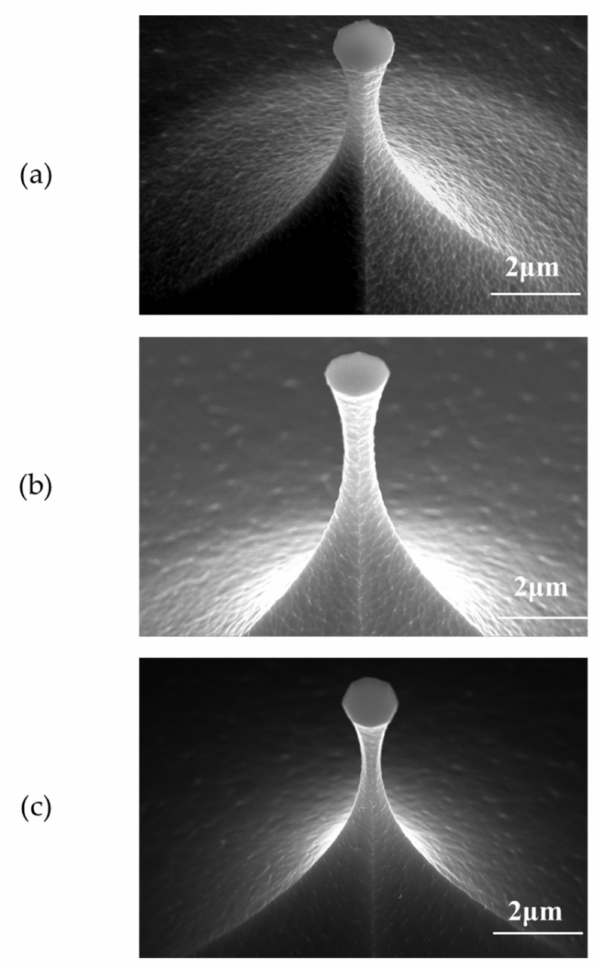
Figure 2. The profiles of the Si tip post etched in different chamber pressures: ( a ) 1.1 Pascal, ( b ) 1.3 Pascal, ( c ) 1.6